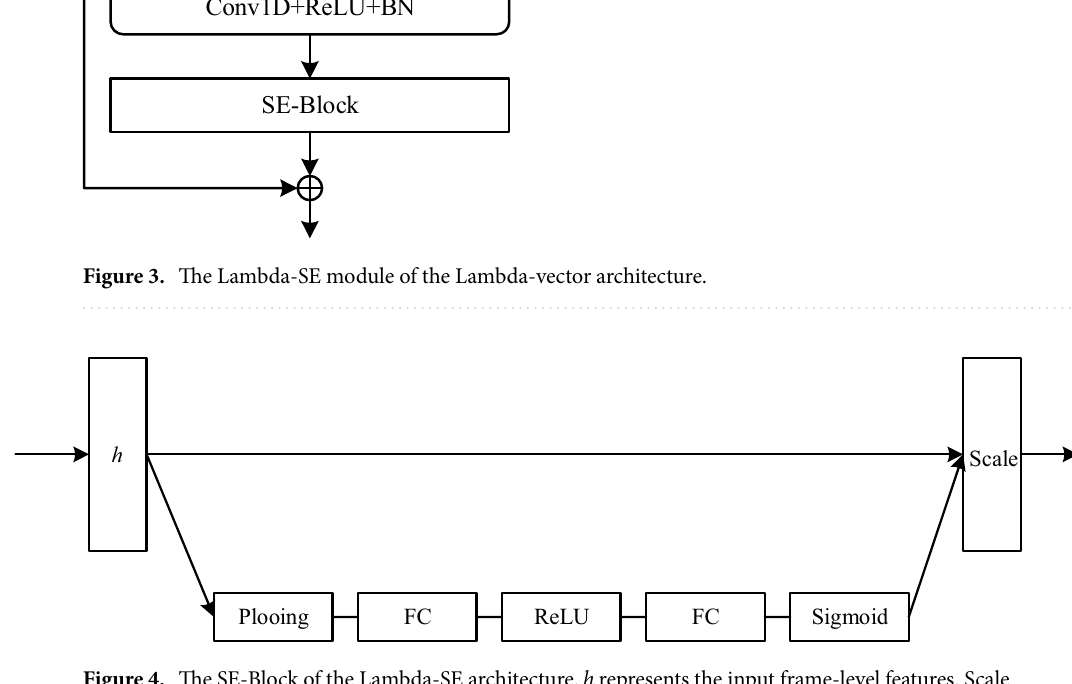
Figure 4. The SE-Block of the Lambda-SE architecture. h represents the input frame-level features. Scale represents the channel-related